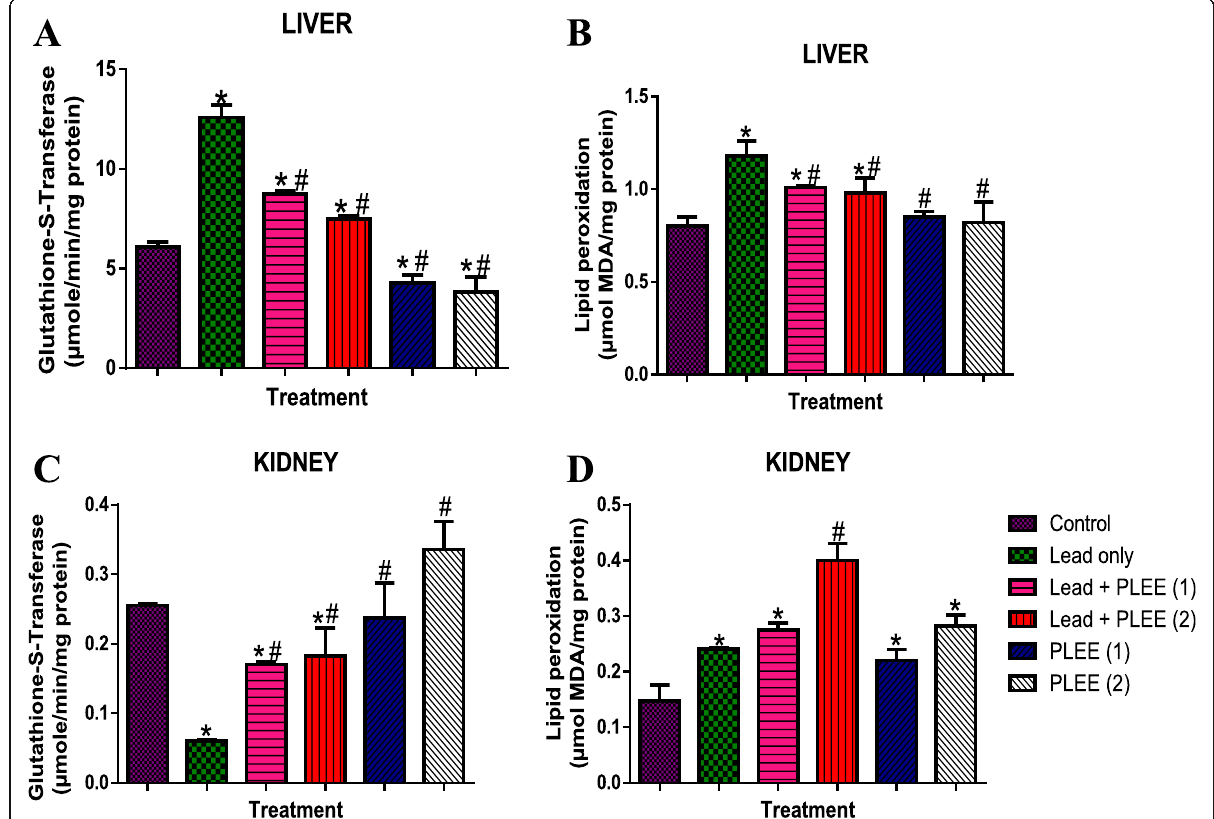
Fig. 4 Changes in the levels of GST and LPO in hepatorenal toxicity induced with lead acetate and treated with PLEE in Wistar rats. Results are represented as Mean ± SD ( n = 5). *- Significantly different from the negative control group, #- significantly different from Lead-only group ( p <